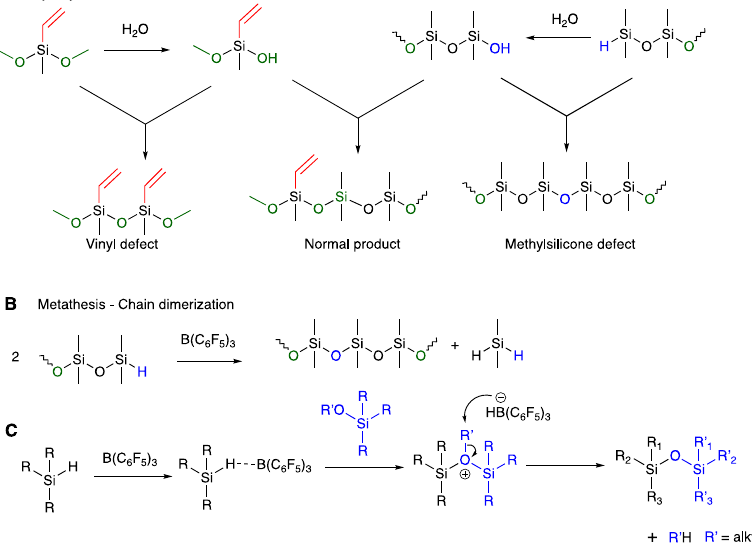
group analysis. c M n obtained of the product obtained by GPC. d macromonomer repeat units [(ViMeSiO) 1 (Me 2 SiO) n ] DP . e MW was too low to be detected by GPC.